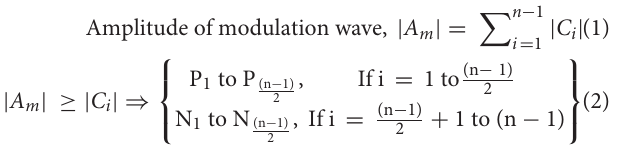
comparison of amplitudes of modulation wave and carrier wave given in Equations (1) and